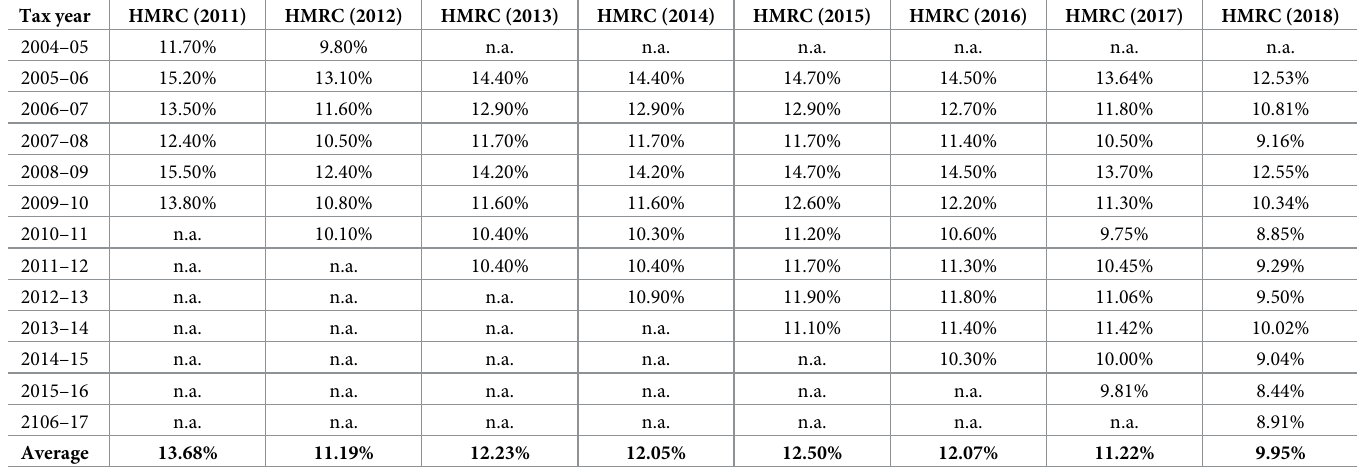
Table 7. The changes in VAT gap estimates from 2011 to 2018 calculated by HM revenues & customs in the United